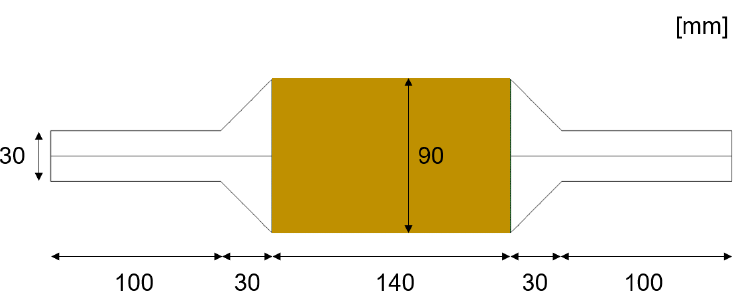
Figure 1. Overview of the computational geometry used in the present work. The flow goes from left to right. The domain is 2D axisymmetric and the horizontal line from the middle of the inlet represents the axis of symmetry. The dark yellow section is the monolith